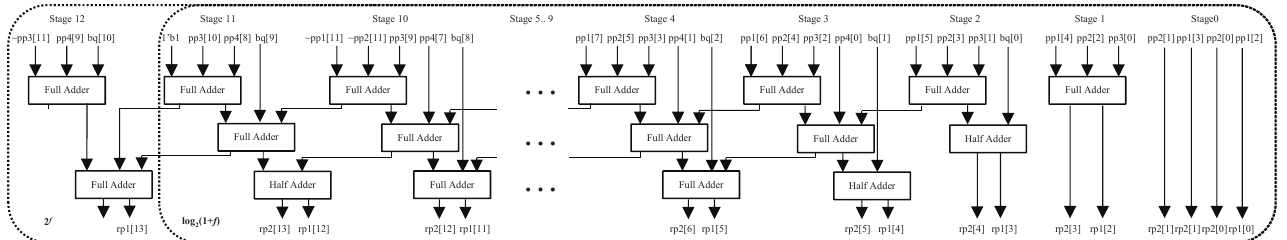
Figure 10. Compressor circuit used in the implementations of 2 f and log and rp2 are the two results of the compressor.